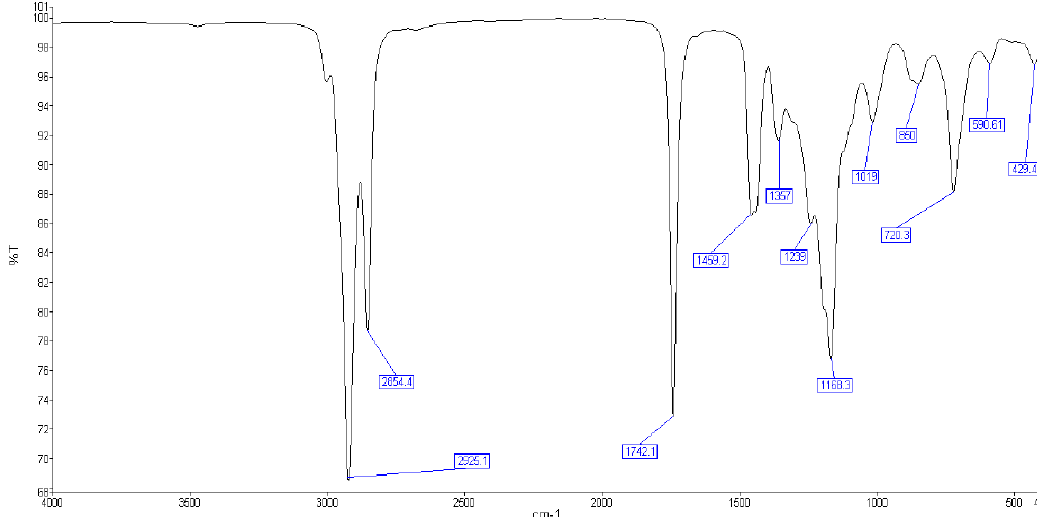
Figure 4. Fourier transform infrared (FT ‐ IR) Spectrum of macadamia biodiesel.